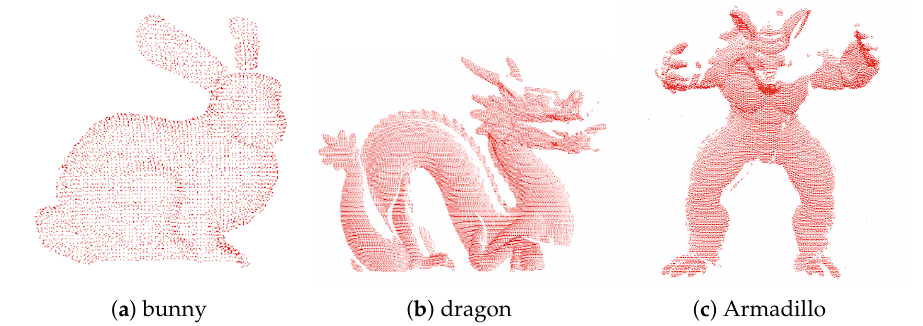
Figure A3. Three point cloud used for